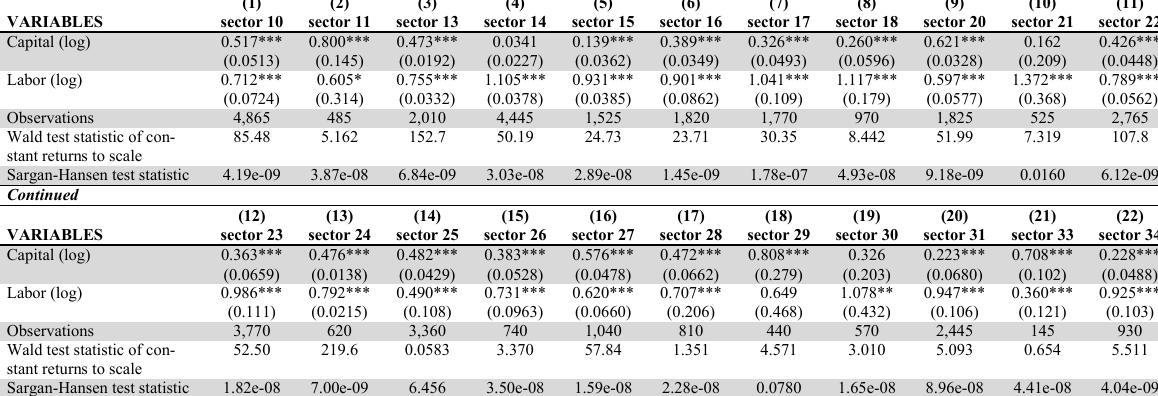
Wald test statistic of con- stant returns to